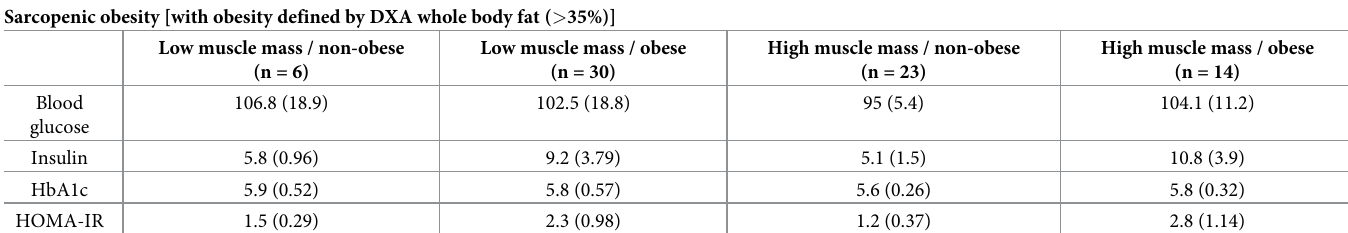
Table 5. Comparison of indices of insulin-glucose homeostasis (mean ± SD) and sarcopenic obesity defined by D 3 Cr muscle mass and percent body fat. Sarcopenic obesity [with obesity defined by DXA whole body fat ( > 35%)] Low muscle mass / non-obese (n =